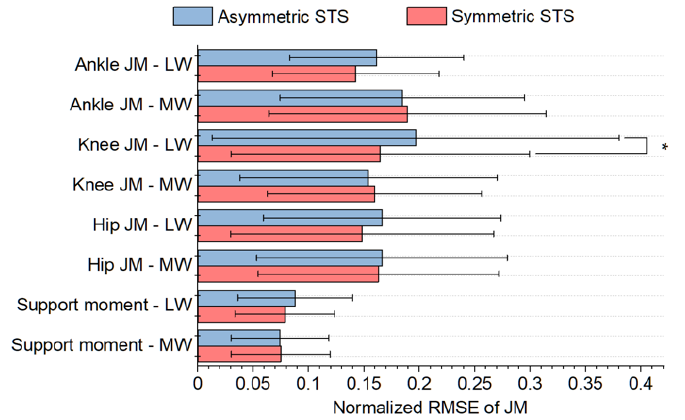
Figure 4. Comparison of RMSEs of normalized JMs and support moment between symmetric and asymmetric STS. Note that LW and MW denote the less weighted side and more weighted side, respectively. * indicate a significant difference ( p < 0.05).